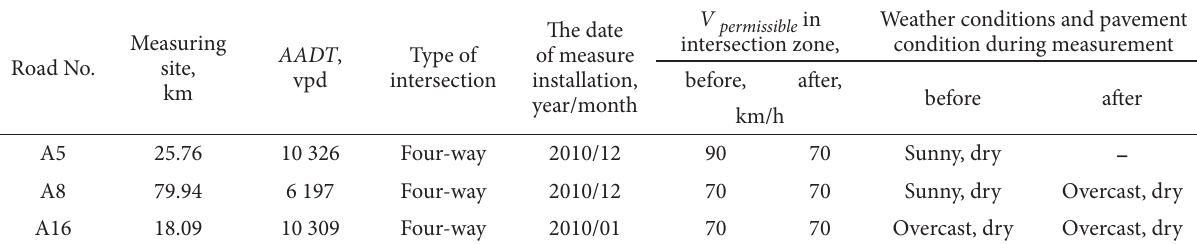
Table 1. Data on the study intersections